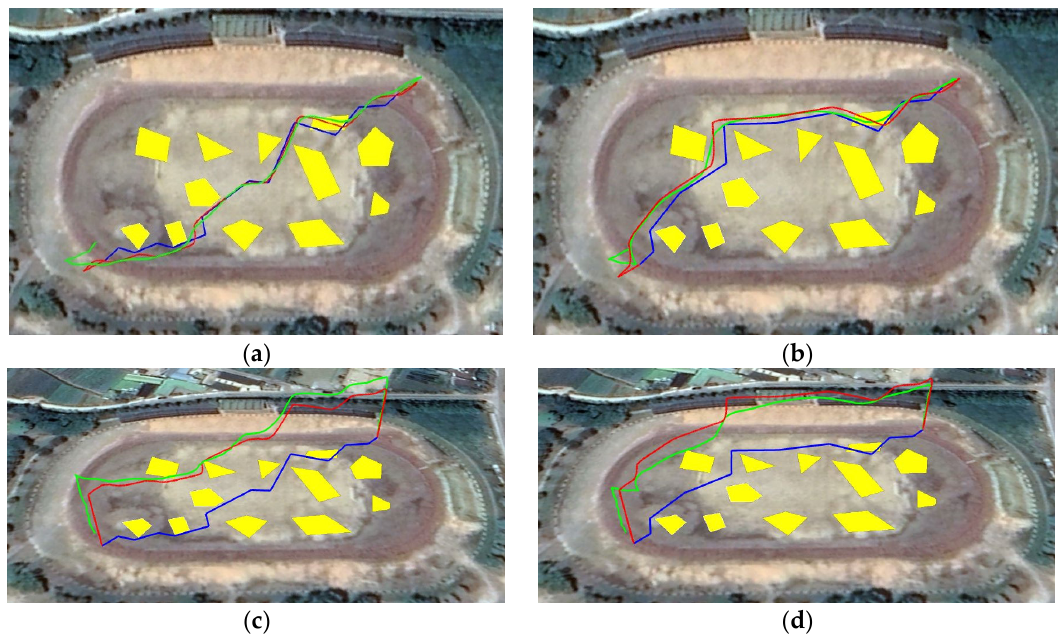
Figure 18. Reference, simulation, and experiment flight trajectories of: ( a ) SPP algorithm (2D), ( b ) EEPP algorithm (2D), ( c ) SPP algorithm (3D), and ( d ) EEPP algorithm (3D).